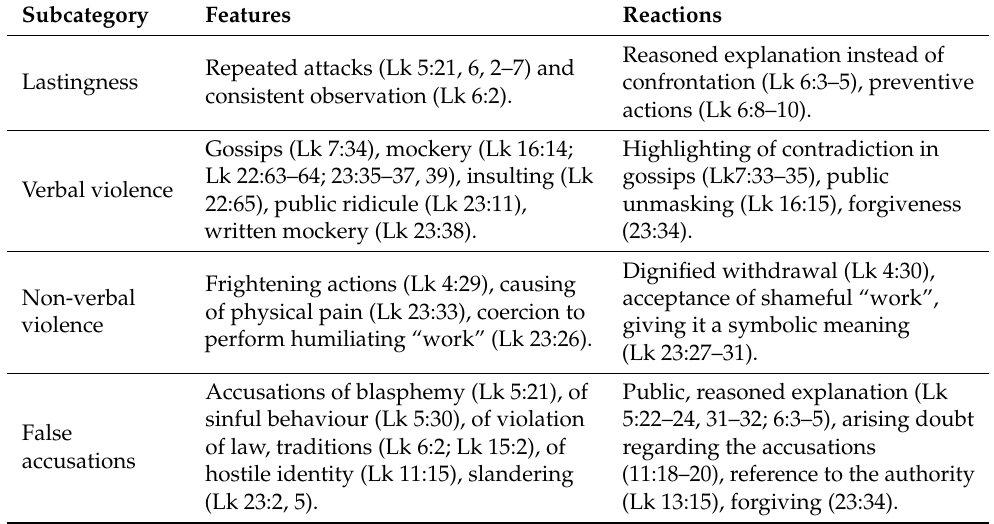
Table 2. Features of